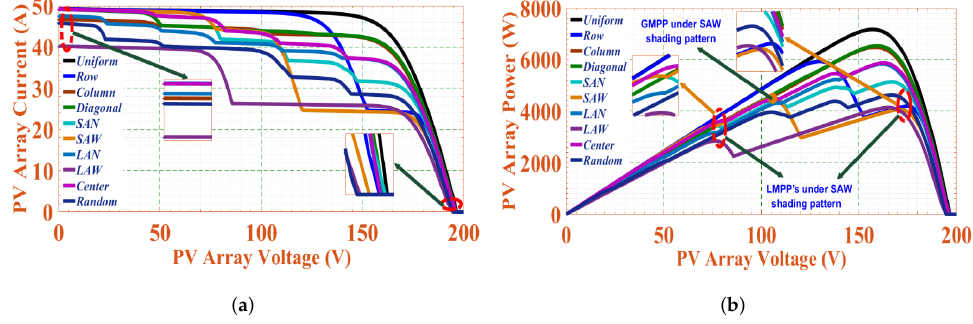
Figure 9. B-L-C-T topology results under various PSCs. ( a ) I-V characteristics, and ( b ) P-V characteristics.